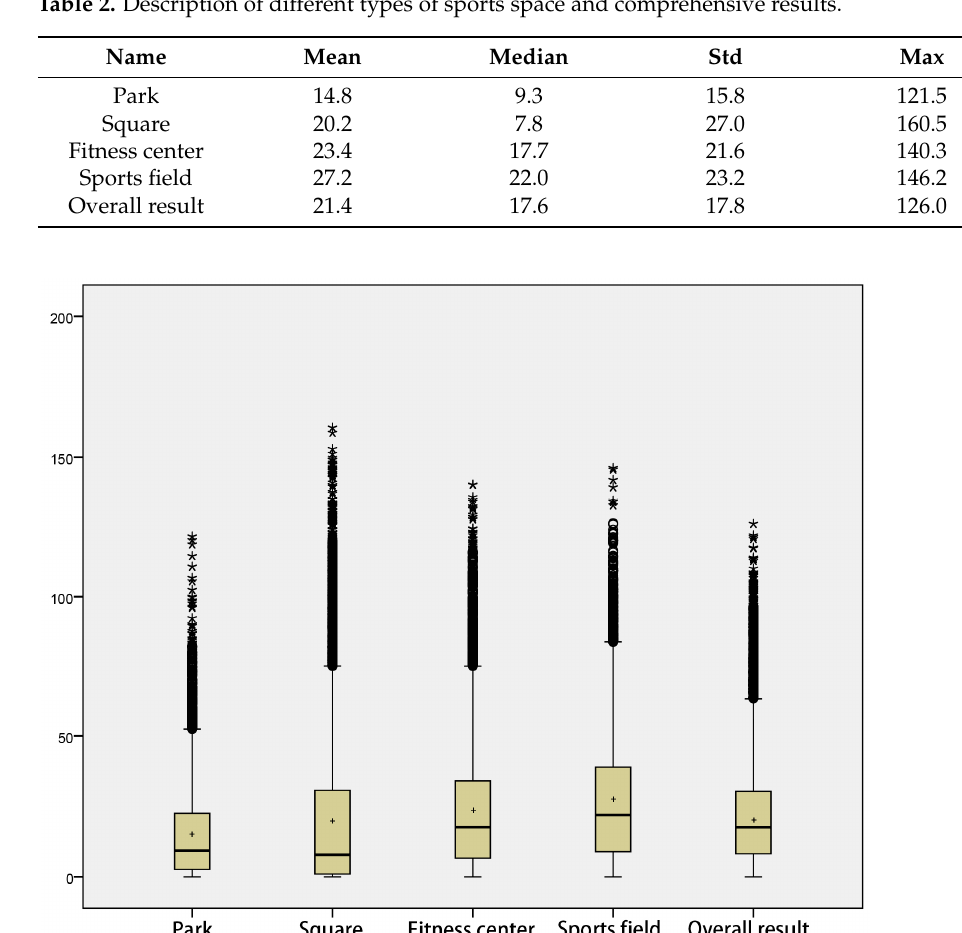
Table 2. Description of different types of sports space and comprehensive results.